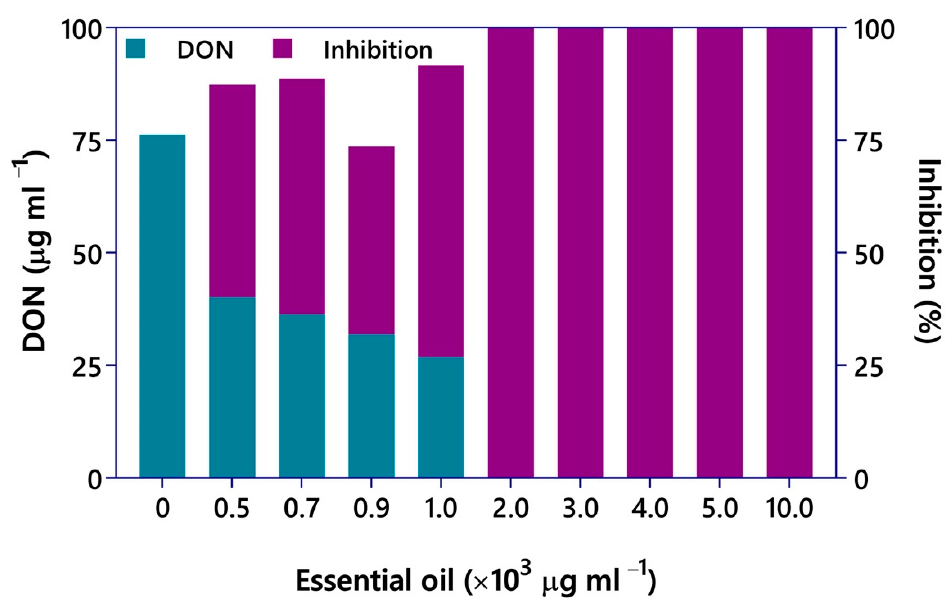
Figure 4. Relationship between Z. officinale EO and mycotoxin deoxynivalenol (DON) synthesis [1].